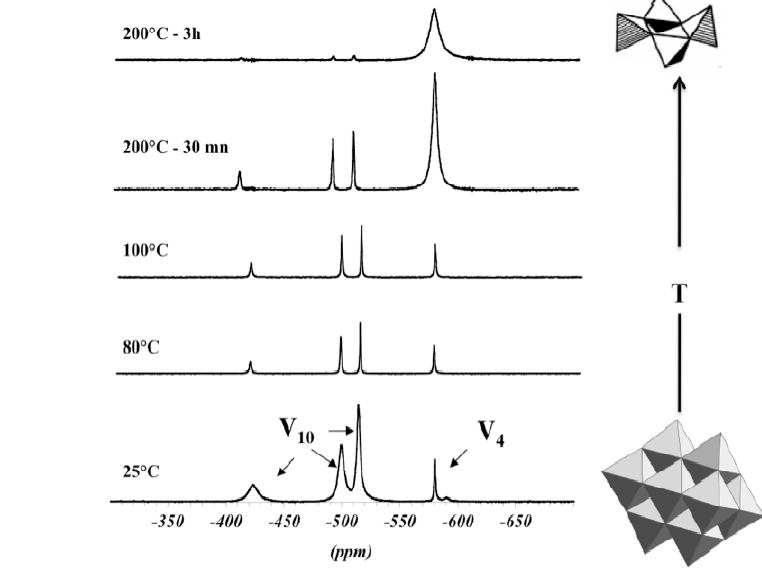
Figure 5. 51 V NMR spectra of a vanadate solution recorded at different